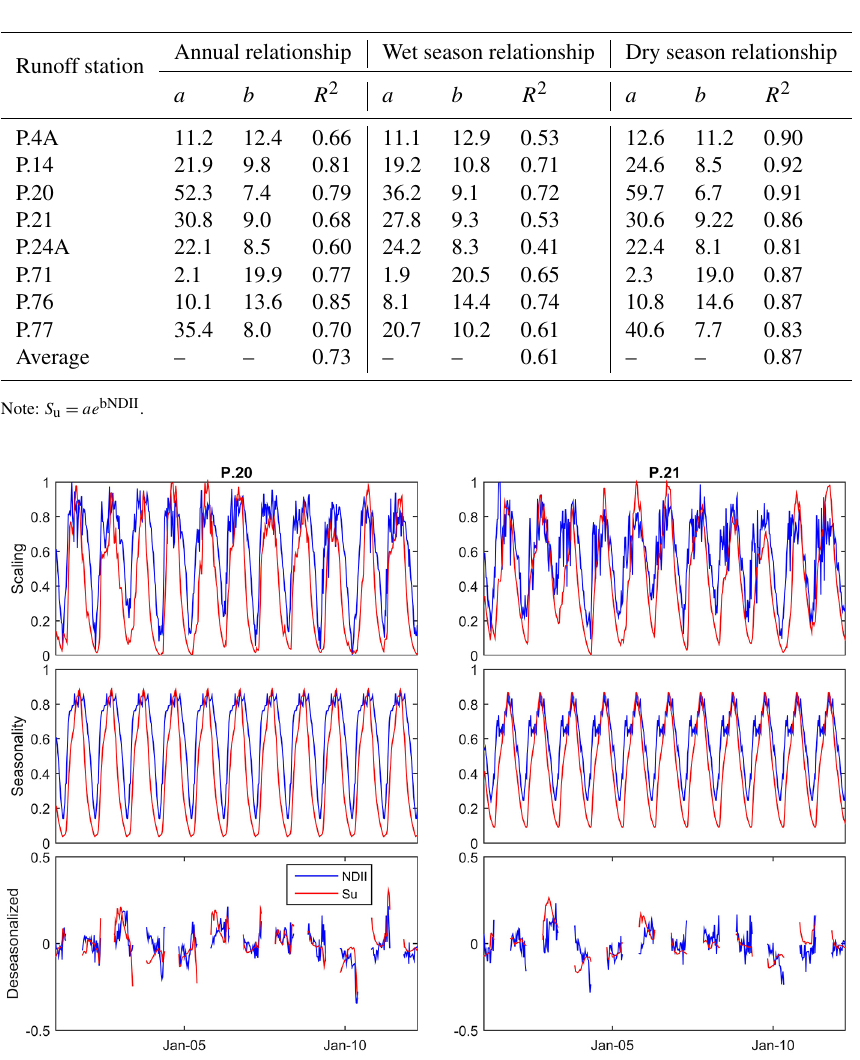
Table 8. Exponential relationships between the average NDII values and simulated root zone moisture storage ( S u ) in the eight sub-basins controlled by the eight runoff stations.